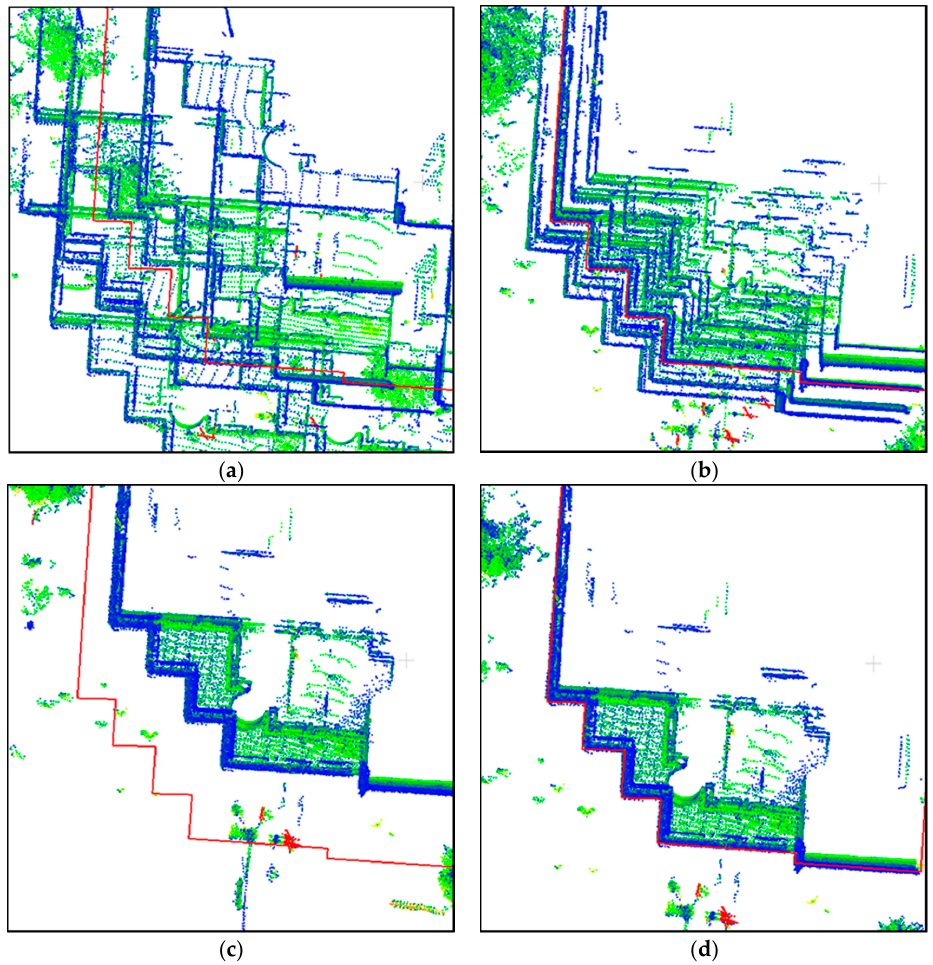
Figure 1. Visualized examples of the effects of the terms “accuracy” and “precision” in mapping (the red polyline is the ground-truth building footprint): ( a ) neither accurate nor precise; ( b ) accurate only; ( c ) precise only; and ( d ) both accurate and precise.